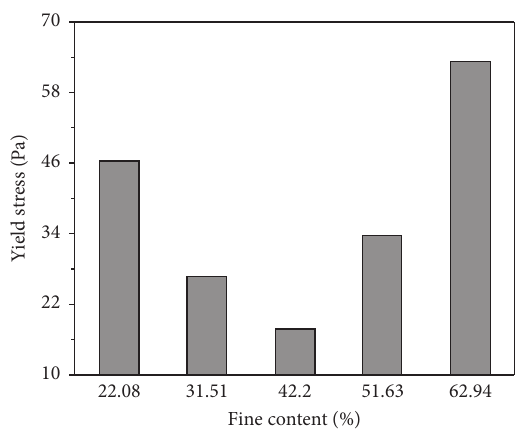
Figure 7: Yield stress variation with fine contents.